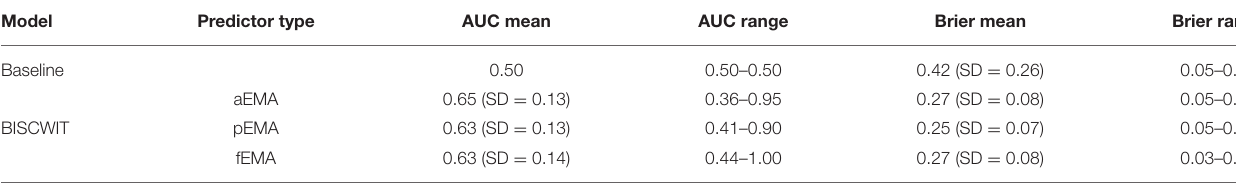
TABLE 1 | Accuracy of predictor ensembles in predicting food craving classes.